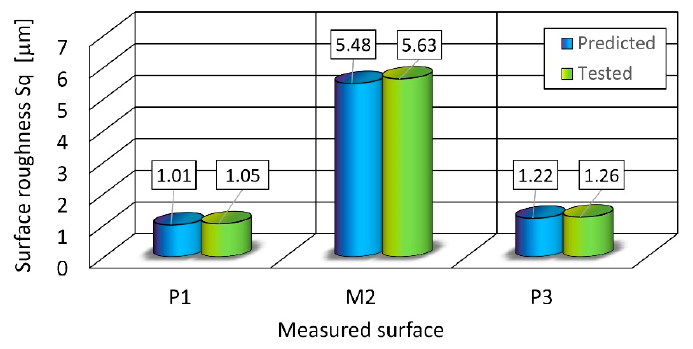
Figure 6. The influence of control parameters on the S/N ratio for surface roughness: ( a ) P1 area, ( b ) M2 area, ( c ) P3 area.